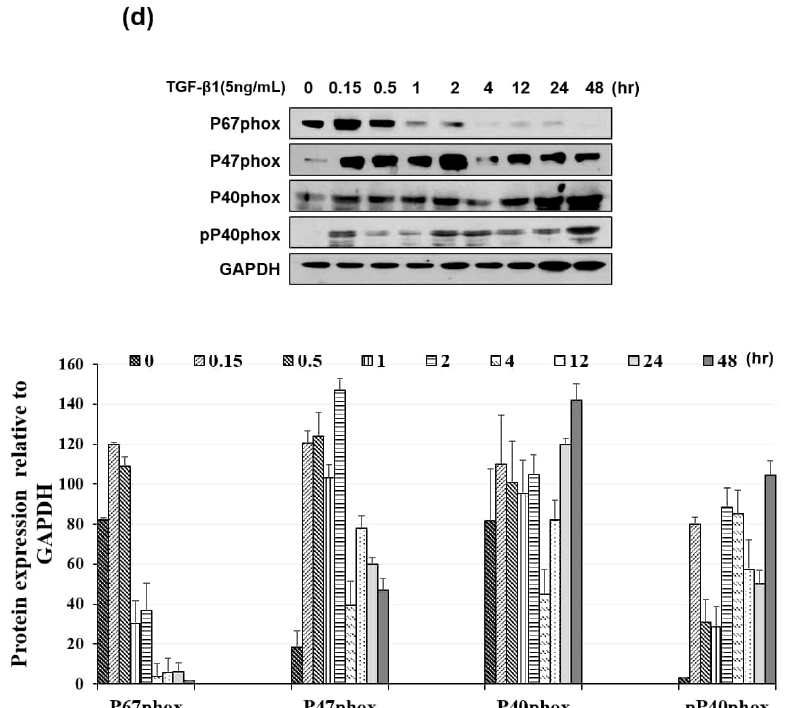
Figure 3. TGF- β 1-induced activation of Smad-dependent and Smad-independent pathway proteins. ( a ) TGF- β 1 (5 ng / mL) altered the expression of epithelial-to-mesenchymal transition (EMT) molecular markers. Cells were treated with TGF- β 1 for 48 h. Total cell lysates were extracted for Western blot analysis of the expression of pSmad2 / 3, ZEB1 / 2, vimentin, and YB-1. GAPDH was used as a loading control. ( b ) E ff ects of TGF- β 1 on phosphorylation of AKT, p38, and ERK1 / 2 MAPKs in a time-dependent manner. HeLa cells were treated with TGF- β 1 for the indicated times. Cell lysates were analyzed by Western blotting with antibodies against phospho-Smad2 / 3, Smad2 / 3, phospho-Akt, Akt, phospho-Erk1 / 2, Erk1 / 2, phospho-p38, and p38MAPK. ( c ) Western blots showing the e ff ects of DPI (5 µ M) on TGF- β 1-induced phosphorylation of AKT, ERK, and P38MAPK. Cells were treated with TGF- β 1 for 48 h. ( d ) Expression of NADPH oxidase subunits including p22phox, p47phox, p67phox, and p40phox induced by TGF- β 1. Assessment of NOX regulatory subunits p22phox, p40phox, p47phox, and p67phox by Western blot analysis. The GAPDH internal control protein was analyzed by Western blotting.